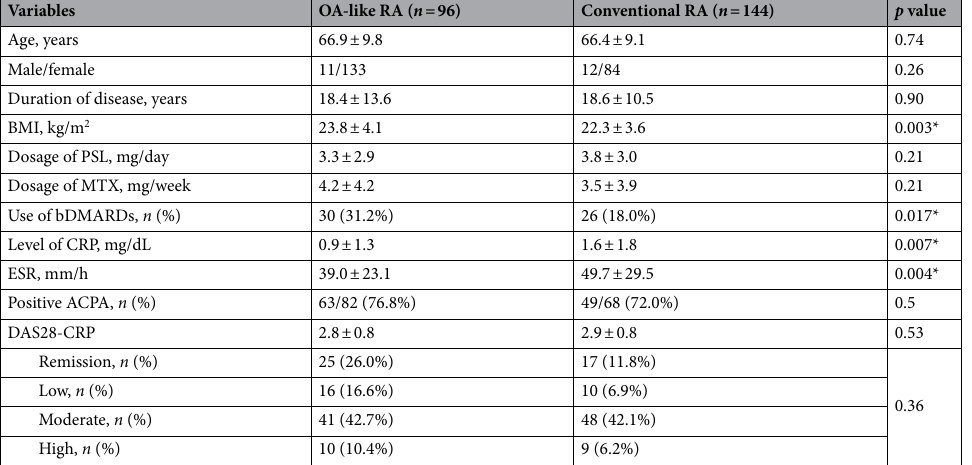
Table 1. Comparison of demographics and clinical data between the OA-like RA and conventional RA groups. Continuous variables are presented as mean ± standard deviation. Categorical variables are presented as number (percentage). *The level of statistical significance was set at p < 0.05. Abbreviations: BMI body mass index, PSL prednisolone, MTX methotrexate, bDMARDs biological disease modifying anti-rheumatic drugs,